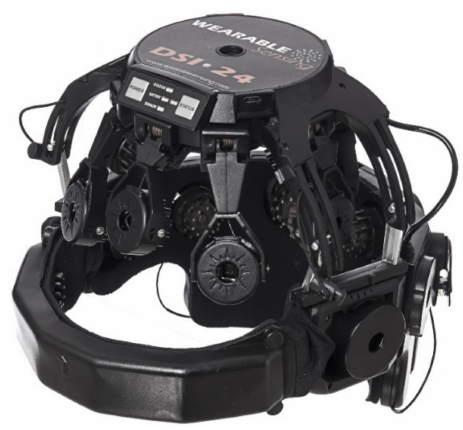
Figure 3. DSI-24